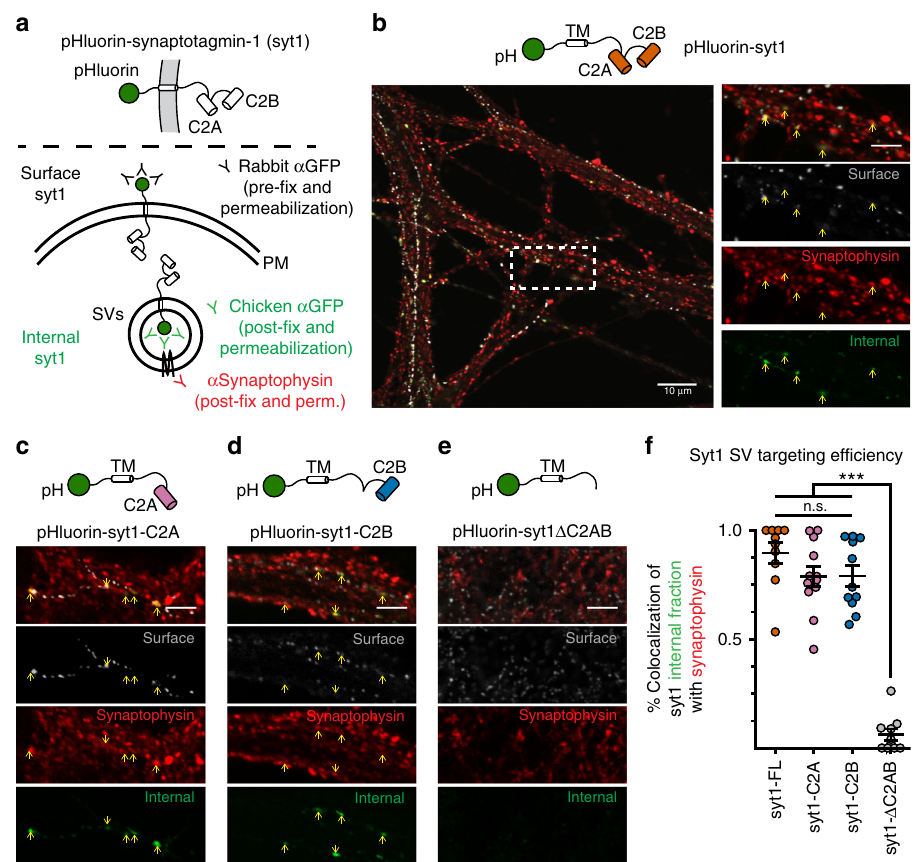
Fig. 1 Either C2-domain of syt1 is suf fi cient for traf fi cking to synaptic vesicles. a Upper: constructs were tagged at the N-terminus with pHluorin and sparsely expressed in syt1 KO neurons. Lower: the tag enabled differential labeling of surface pHluorin from internalized pHluorin, using separate antibodies and a modi fi ed immunocytochemistry protocol. b Full-length syt1 (syt1-FL) was present both on the surface of the plasma membrane (gray) and in internal compartments (green). These internal compartments colocalized with a synaptic marker (synaptophysin, red), con fi rming that the fusion protein properly traf fi cked to synaptic vesicles. c , d . Syt1-C2A ( c ) and syt1-C2B ( d ) were also internalized (green) on synaptic vesicles, again marked by synaptophysin (red). e While a syt1 construct lacking both C2 domains traf fi cked to the surface (gray), this deletion mutant was seldom internalized (green). f Quanti fi cation of the colocalization of the internal fraction of each construct with synaptophysin. For panels b through c , scale bars in the zoomed images represent 5 µ m. For all Figures, * p < 0.05, ** p < 0.01; *** p < 0.001; n.s. indicates p > 0.05. Please see Supplementary Table 1 for the relevant data and statistics in this and all following data. Error bars represent